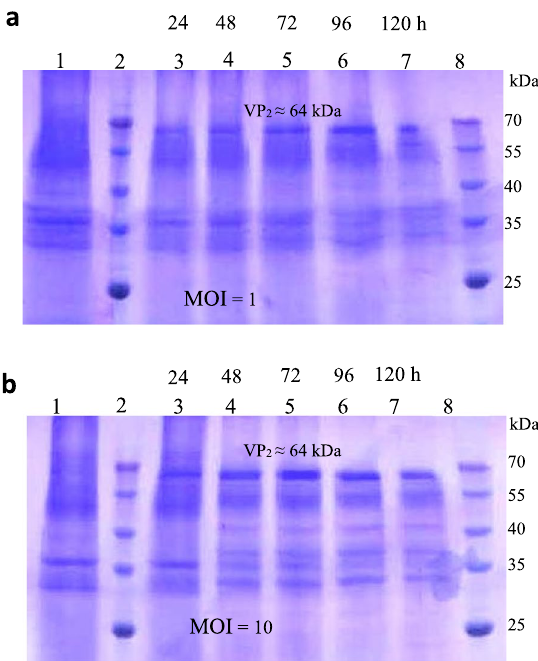
Fig. 3 SDS-PAGE results of the proteins extracted from the Sf9 cells infected by the recombinant baculoviruses encoding VP2. a The proteome of the cells infected with MOI of 1 (pfu/cell) and b the proteome of the cells infected with MOI of 10 (pfu/cell). Lane 1: The cell control, lanes 2 and 8: Molecular weight marker (Fermentas) and lanes 3–7: The protein samples taken at the harvest times of 24, 48, 72, 96, and 120 hpi, and the expected band ( ⁓ 64 kDa) corresponding to the recombinant expressed VP2